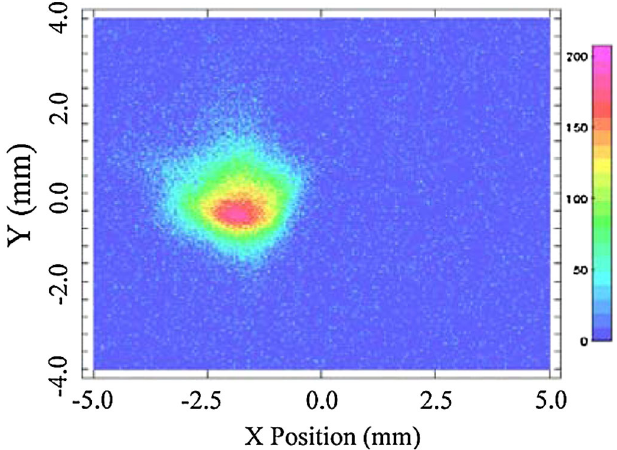
FIG. 16. (Color) An example OTR image of the TC rf gun beam at the 375-MeV station with maximum compression in the chicane. No localized spatial spikes are evident.